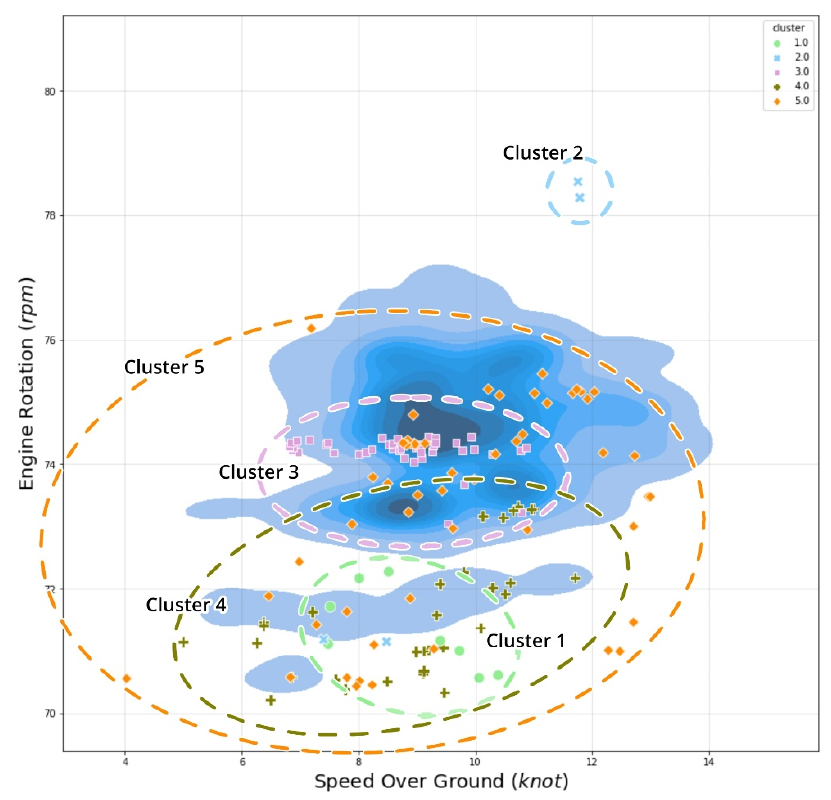
Figure 15. Speed vs. RPM cross plot comparison with cluster distribution.